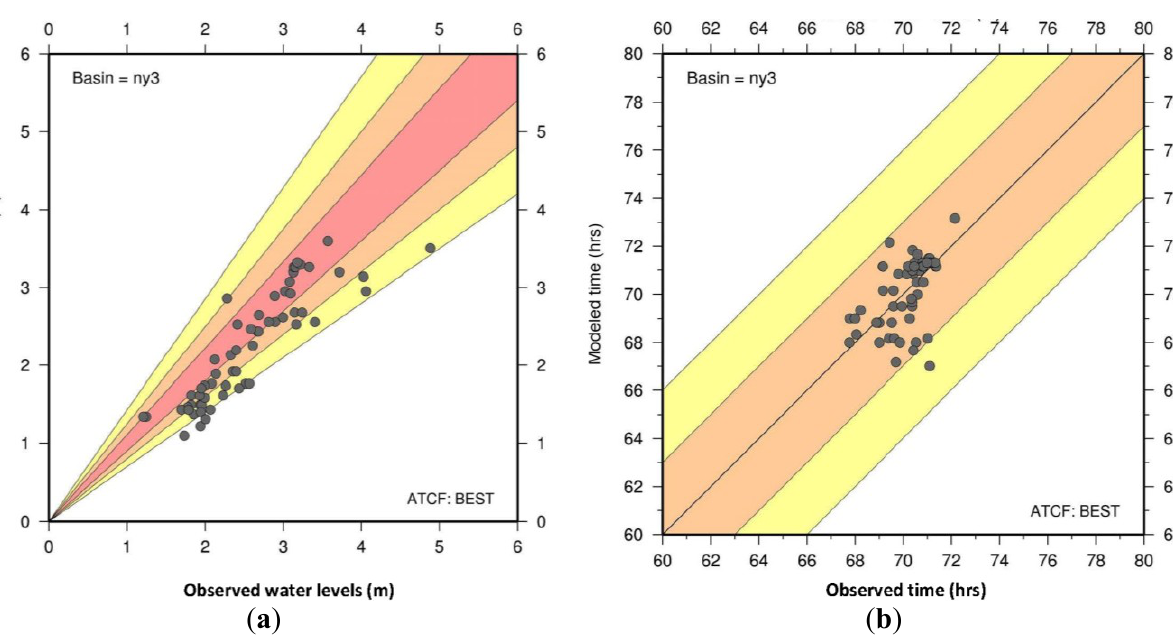
Figure 14. USGS SSS sensor vs. SLOSH-simulated surge-plus-tides ( a ) maximum water levels (m) and ( b ) time-of-arrival (hours) of the peak water levels. In ( a ), the dark orange cone depicts the 10% error, the orange cone depicts 20% error and the yellow cone depicts the 30% error. The water surface elevation errors at most sensors are within the 10%–20% range. In ( b ) the stations that fall in the ±3 h error range for the timing of the peak are within the orange band and the ±6 h error range are within the yellow band. Most sensors’ observed vs. modeled peak arrival times are within 3 h.